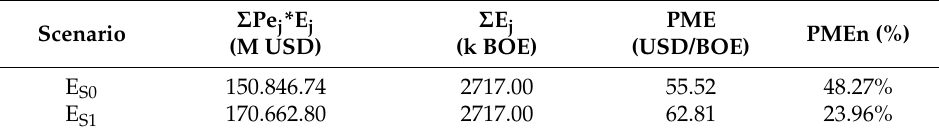
Table 15. The average price of